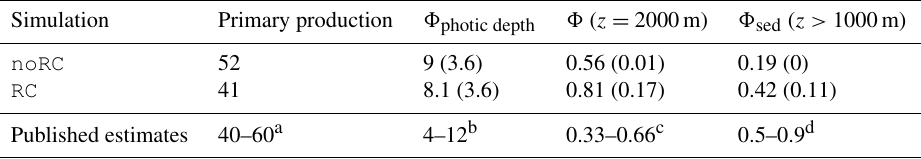
Table 4. Primary production and fluxes of POC ( (cid:56) ) integrated over the global ocean for the different simulations, and estimates based on observations. All numbers are in units of PgCyear − 1 of carbon. The numbers in parentheses denote the fluxes due to small POC. The photic depth is defined as the depth at which photosynthetic available radiation equals 1% of the value at the ocean surface. (cid:56) sed ( z > 1000m) is the flux of POC to the sediments whose depth is deeper than 1000m.